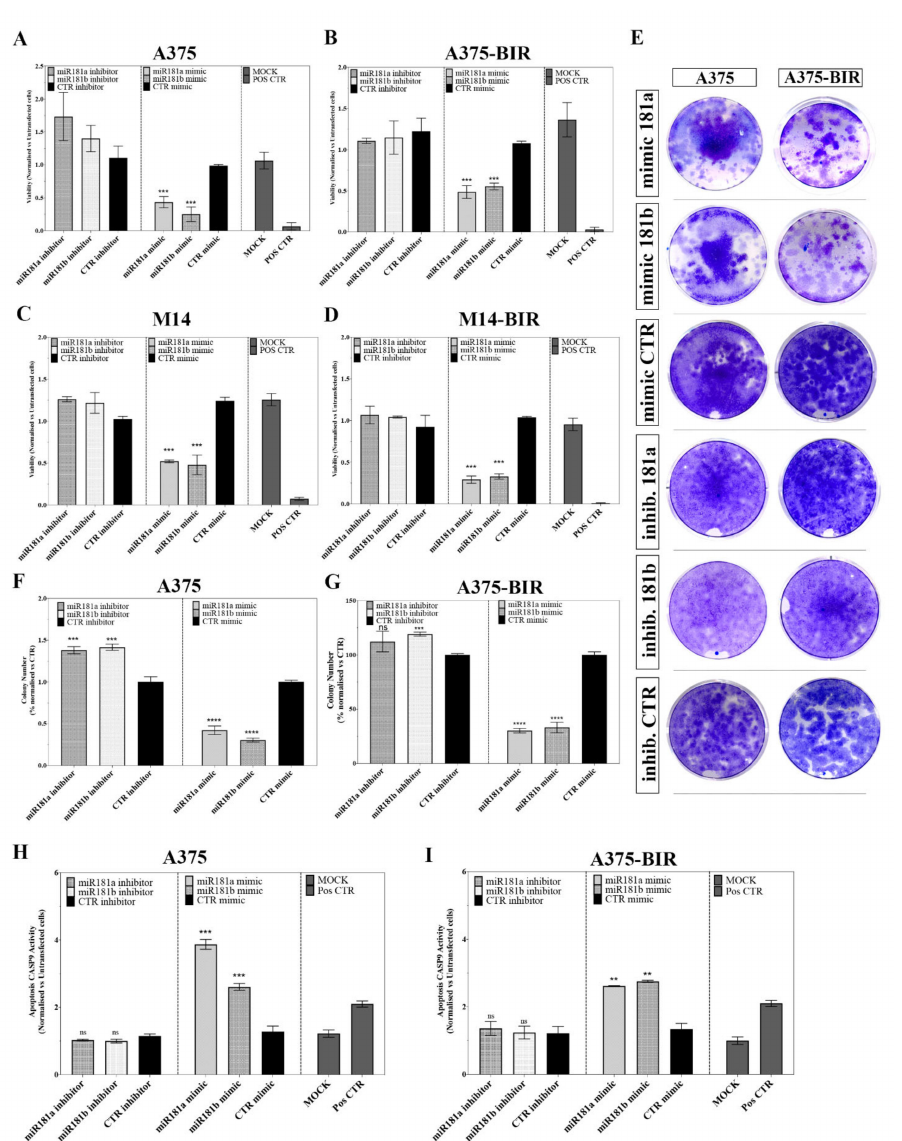
Figure 2. ( A,B ) A375 and A375-BIR cells were transiently transfected with 40 nM of the miR-181a and -181b mimic or inhibitor or the appropriate controls and assayed for proliferation by the MTT viability assay. Data are expressed in terms of percentage of cell viability as compared to untransfected cells. Each value represents the arithmetic mean of three independent experiments performed with triplicate samples. *** p < 0.001. ( C , D ) M14 and M14-BIR cells were transiently transfected with 40 nM of the miR-181a and -181b mimic or inhibitor or the appropriate controls and assayed for proliferation by the MTT assay. Data are expressed in terms of percentage of cell viability as compared to untransfected cells. Each value represents the arithmetic mean of three independent experiments performed